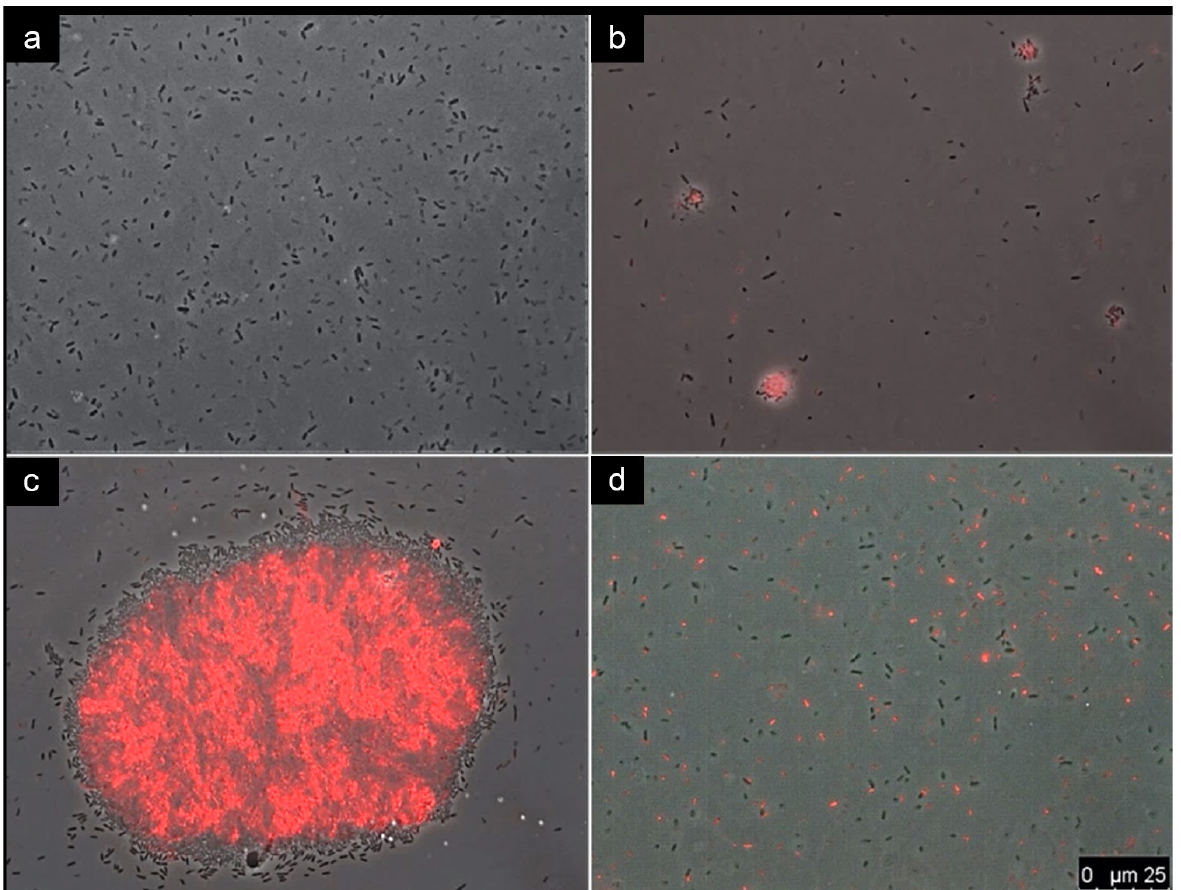
Figure 1. Representative fluorescence microscopy images of JX05 clinical isolate. (a) Untreated bacteria; (b) Bacteria treated with QDs-MPM conjugates; (c) Bacteria treated QDs-MPM conjugates and an excess of free MPM, and (d) Bacteria treated with QDs-MPM conjugate and an excess of free MPM, combined with AZT. Micrographs show the overlapping of fluorescence (BP 645/75 nm) and phase-contrast images. Scale bar: 25